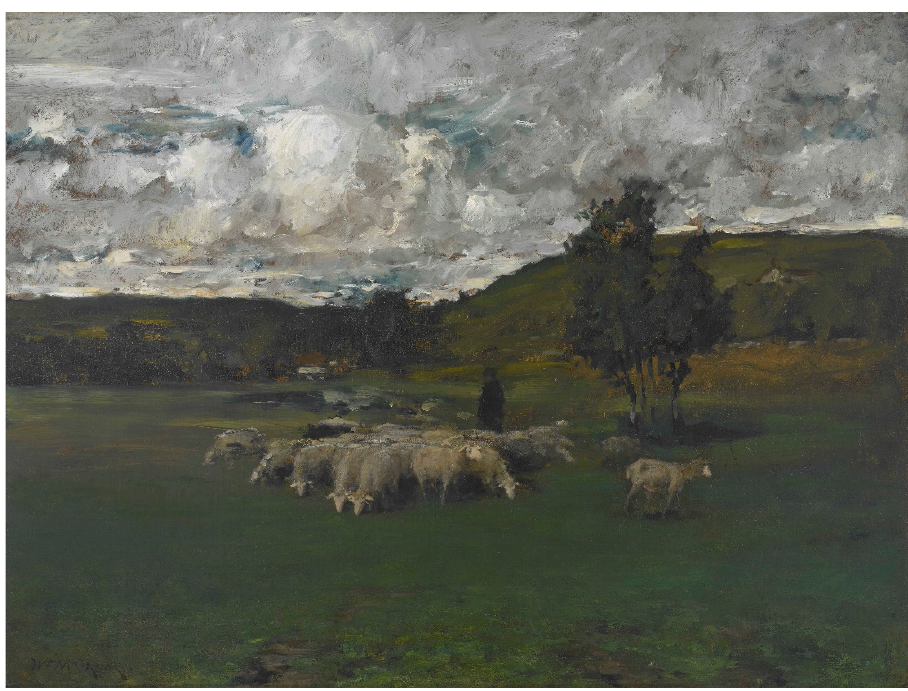
Figure 12. William Merritt Chase View near Polling (Landscape with Sheep) , ca. 1875, oil on canvas, 92.1 × 121.9 cm, Courtesy Crystal Bridges Museum of American Art, Bentonville, Arkansas. Photography by Dwight Primiano.